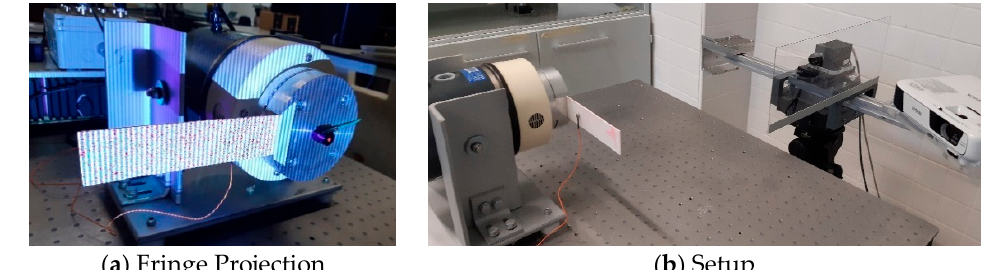
Figure 3. ODS test setup.